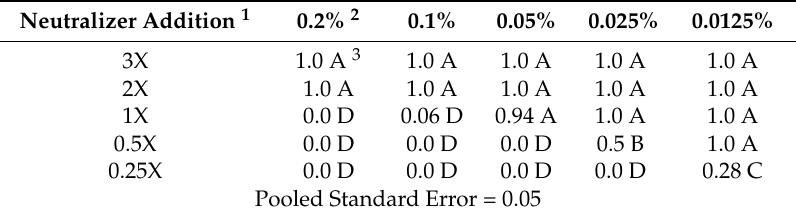
Table 2. Least squares means of the frequencies of Salmonella growth or non-growth (number of samples showing growth or non-growth/total number samples) as affected by the interaction of peracetic acid (PAA) concentration x combined neutralizers addition ( p <